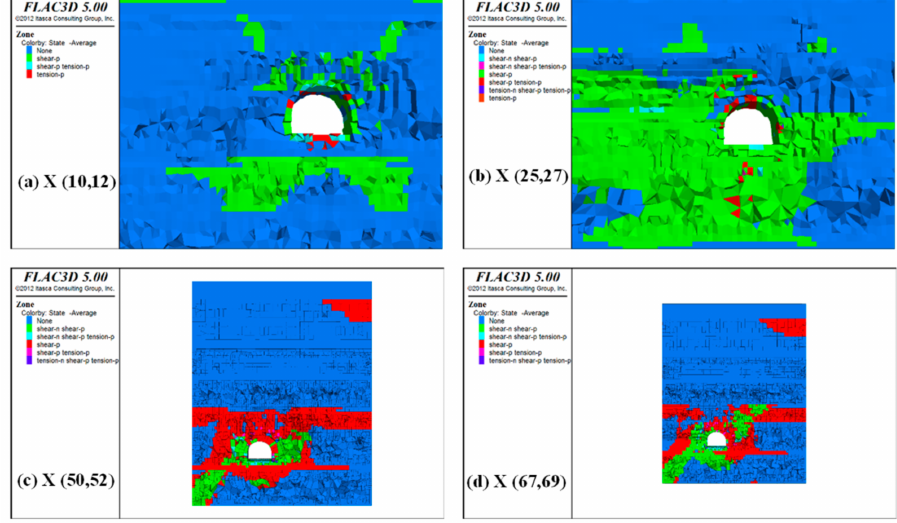
Figure 7. Plastic zone range of the four monitoring areas without excavation